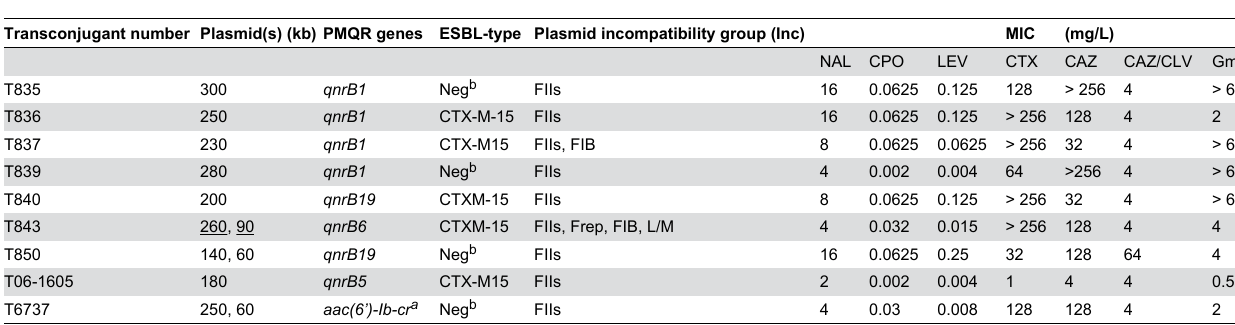
Table 4. Genetic characteristics of the transconjugants that acquired PMQR